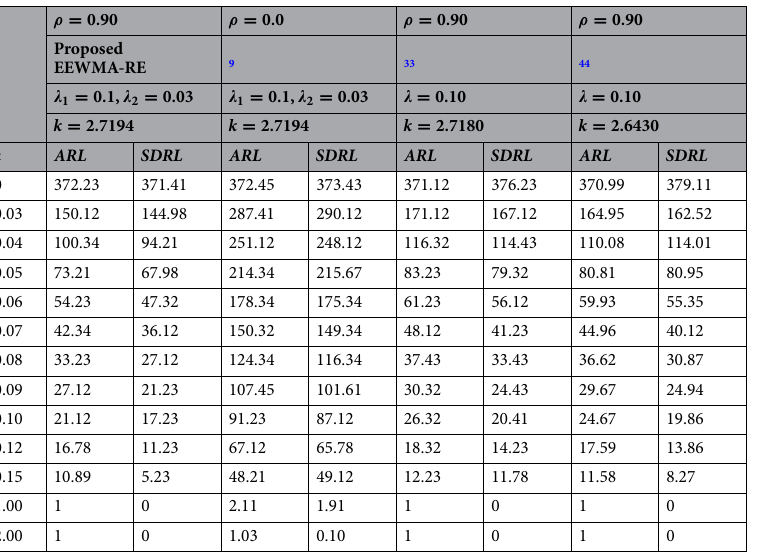
Table 10. Comparisons of the proposed EEWMA-RE control chart versus existing charts when = 370, n = 5 ARL 0